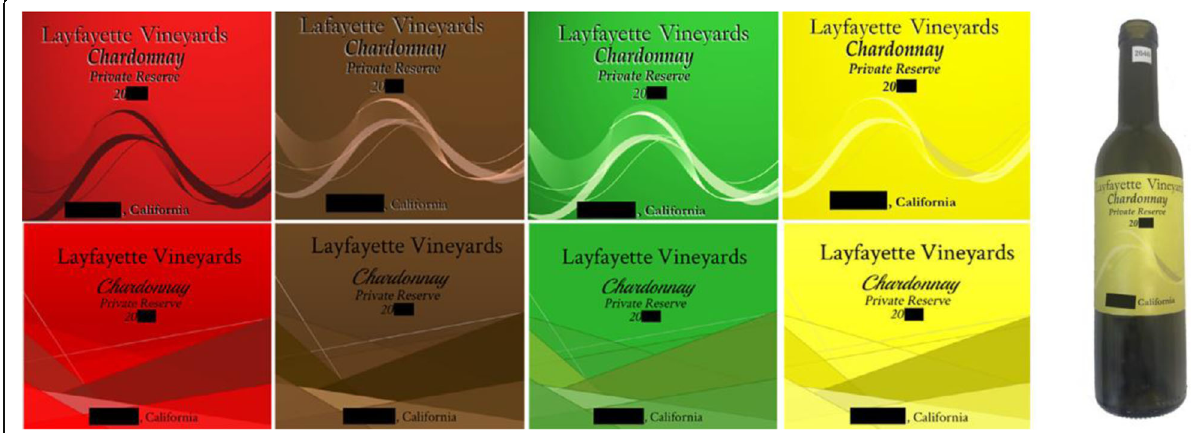
Fig. 3 Wine labels affixed to wine bottles (comprising 2 levels of angularity – rounded and sharp) as well as four colours (red, brown, yellow, and green). Heatherly et al. (2019) assessed the orthonasal olfactory expectations set by these wine labels, (see online version for colour